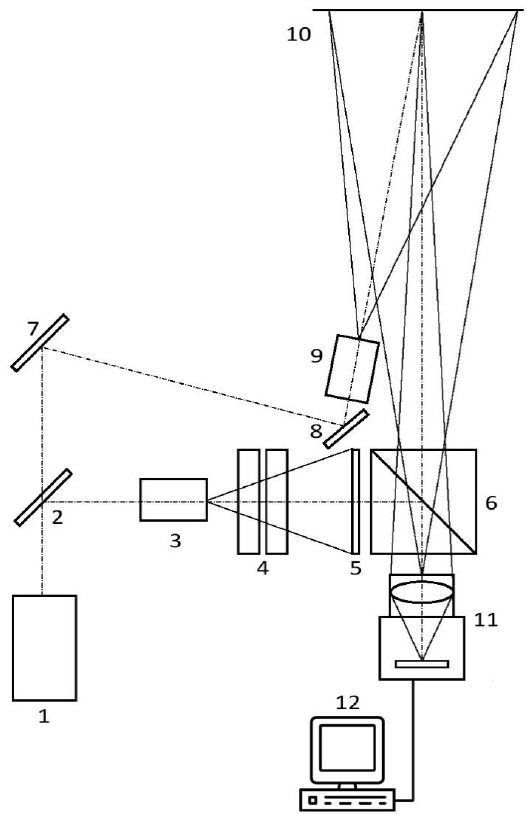
Figure 2. Schematic drawing of the ESPI interferometer: 1—laser, 2—plate beam splitter, 3 and 9—diverging lenses (100× microscope objective lens), 4—polarizers, 5—diffuser made of ground glass with a reference surface, 6—beam combiner, 7 and 8—mirrors, 10—object surface, 11—digital camera (CMOS), 12—computer.